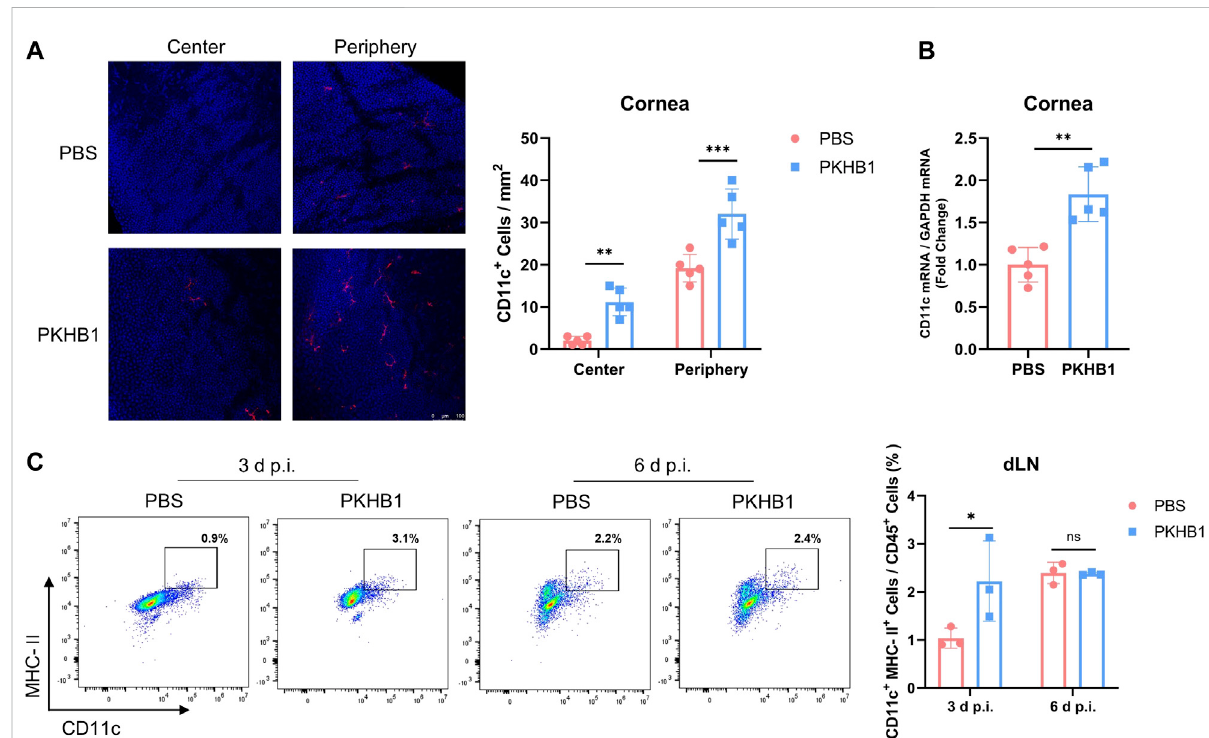
FIGURE 4 Subconjunctival injection of PKHB1 peptide increased the number of DCs on the ocular surface and in the dLNs. Representative micrographs and bar charts (A) of cells expressing CD11c (dendritic cell maker) in the central and peripheral corneas after different treatments (20 ×) ( n = 5). (B) Detection of transcriptional levels of mouse corneal CD11c by qRT-PCR with GAPDH as an internal reference ( n = 5). Representative fl ow cytometry plots and bar charts (C) showing the frequency of CD45 + CD11c + MHC- II + DCs in dLNs of PKHB1 peptide or PBS topically treated HSK mice at 3dp.i.and6dp.i.( n =3).PKHB1peptideincreasedthenumberofDCsinthedLNsintheearlystagesofinfection.Datawerepresentedasmean±SD of three independent experiments. (* p < 0.05, ** p < 0.01, *** p <